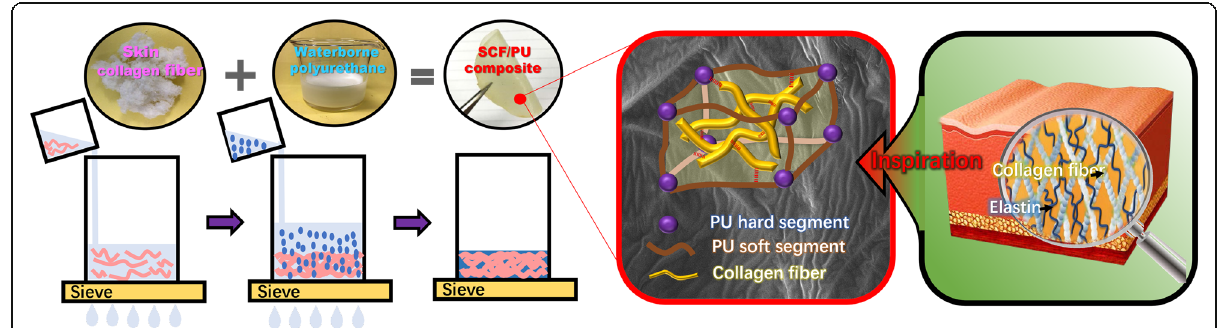
Fig. 8 facile preparation of SC/PU composite inspired from dual-network of natural skin [68], Copyright (2019), with permission from RSC publication